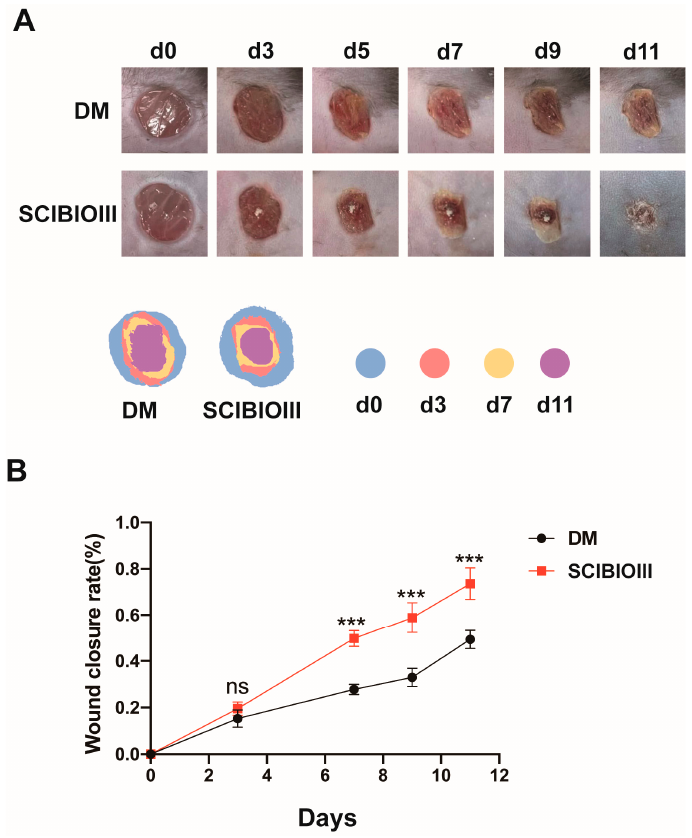
Figure 5. SCIBIOIII hydrogel accelerates wound closure in diabetic mice. ( A ) Photographs of skin wounds (representative images) and signs of wound closure within 11 days were recorded at the specified times ( n = 5). (B) Wound recovery rates from day 0 to 11 were calculated based on images of the wounds ( n = 10 wounds). ns p > 0.05, *** p < 0.001.